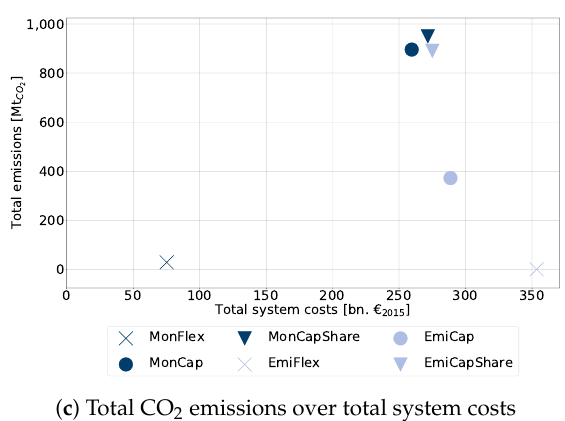
Figure 6. Comparison of annualized total system costs and total